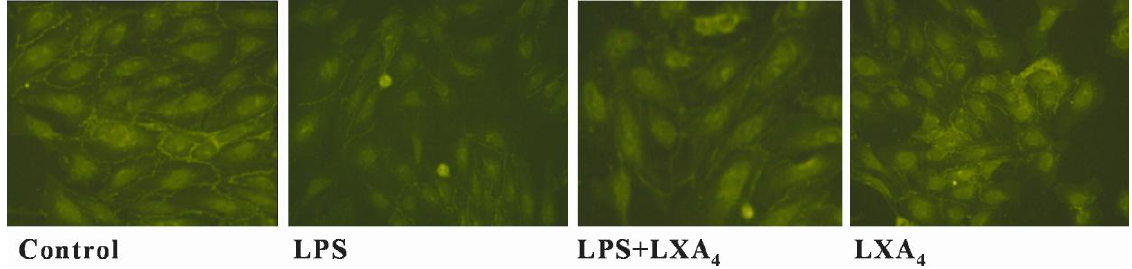
FIGURE 4. VE-cadherin protein expression detected by immunofluorescence. Representative images were from one of three separate experiments that yielded similar